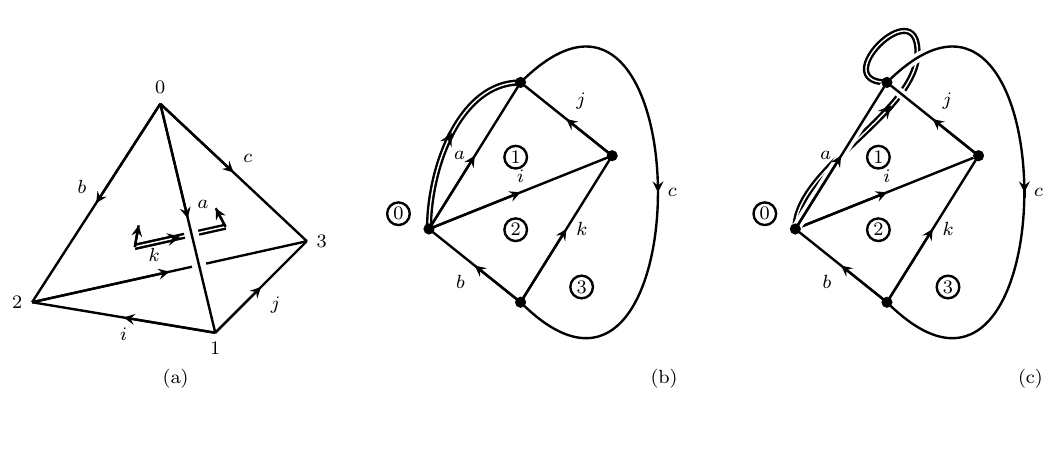
Figure 32 . a) A tetrahedron with an extra quasi-particle transversing two faces. We indicated the choice of framing at each face. b) The dual planar graph in the spherical fusion category. We drew the center line along the simplest choice of path. Alternative paths which self-intersect or